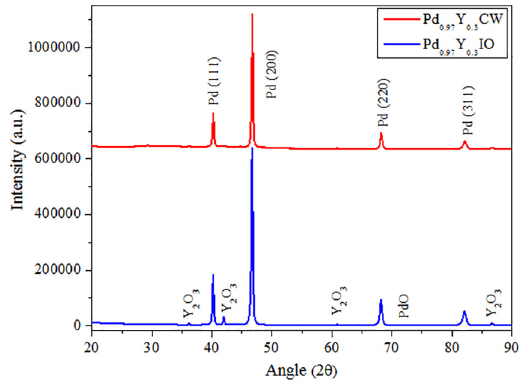
Figure 2. X-ray diffraction patterns for the Pd worked and oxidized at 800ºC per 24h.